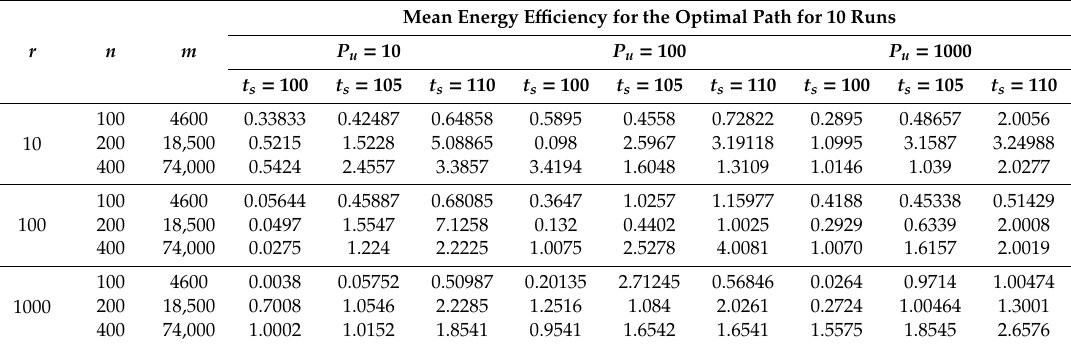
Table 13. Mean energy e ffi ciency for the e ff ective path for the SESE algorithm for 10 Mb . Mean Energy E ffi ciency for the Optimal Path for 10 r n m